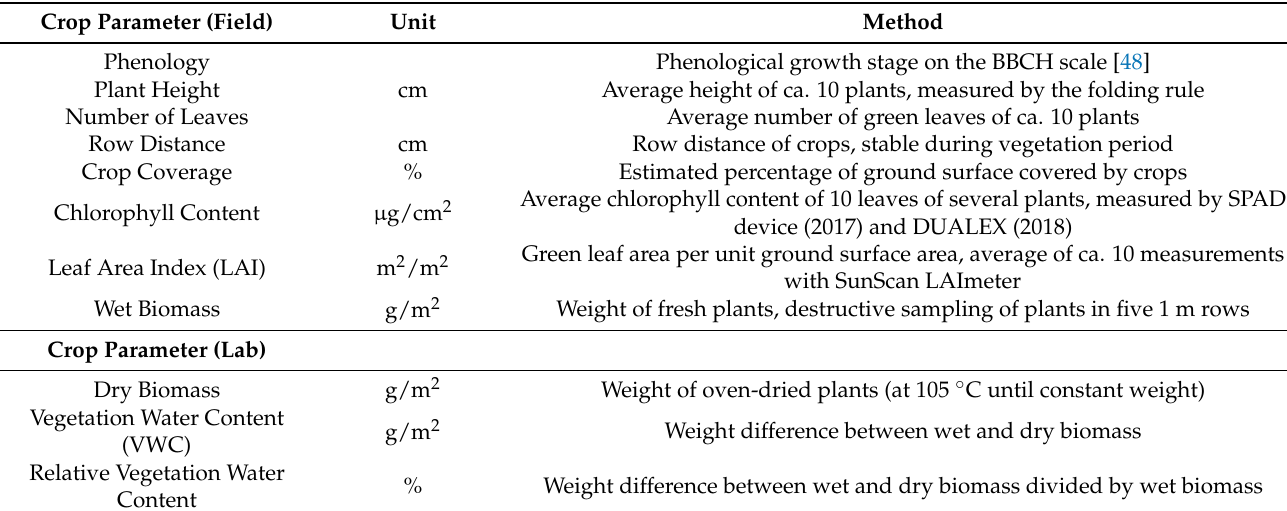
Table 2. Crop parameters obtained during field campaigns 2017 and